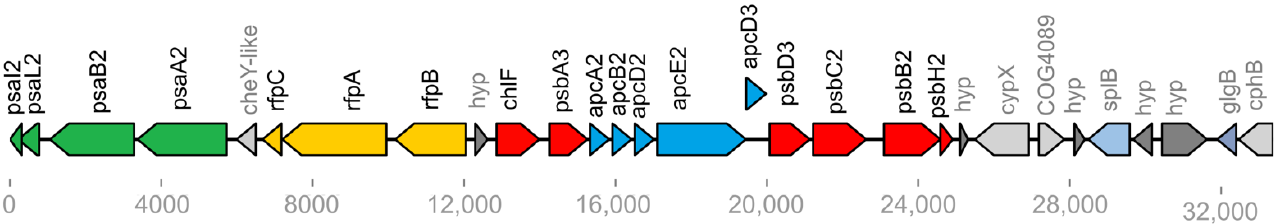
Figure 5. Gene map of the FaRLiP gene cluster found in the MAG of Chroococcidiopsis G-MTQ-3P2. Paralogs of PSII are in red, paralogs of PSII are in green, paralogs of phycobiliproteins are in blue, and regulatory genes are in yellow. Hypothetical genes are in dark grey, and genes involving other processes are in light blue and light